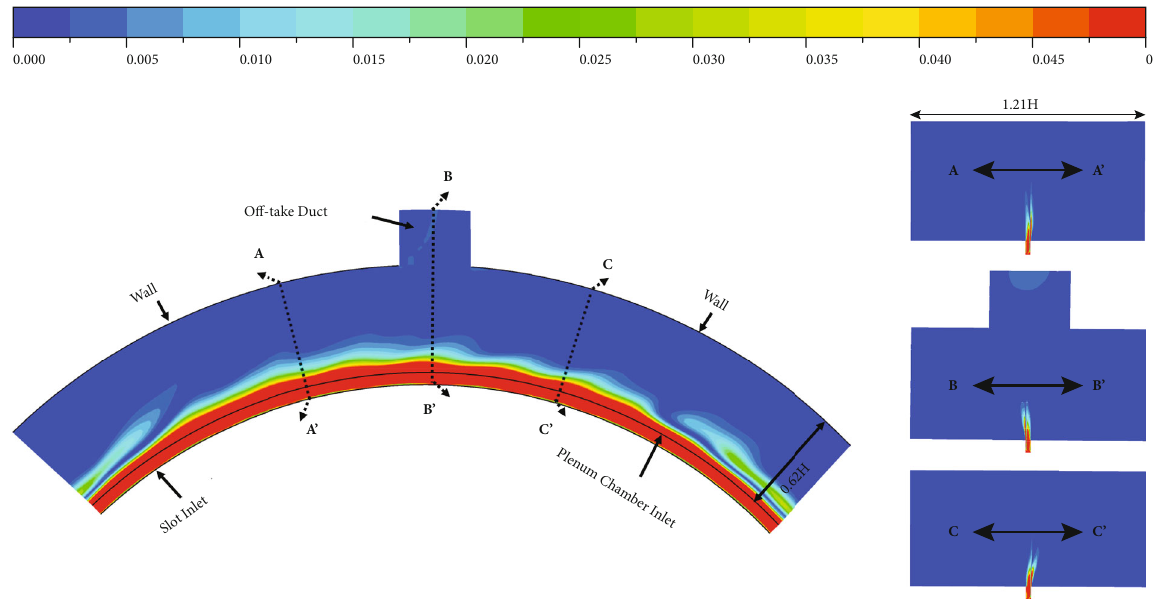
Figure 15: Normalized entropy generation rate of bleed system for plenum chamber with a radial height of 0.62 H and an axial width of 1.21 H .